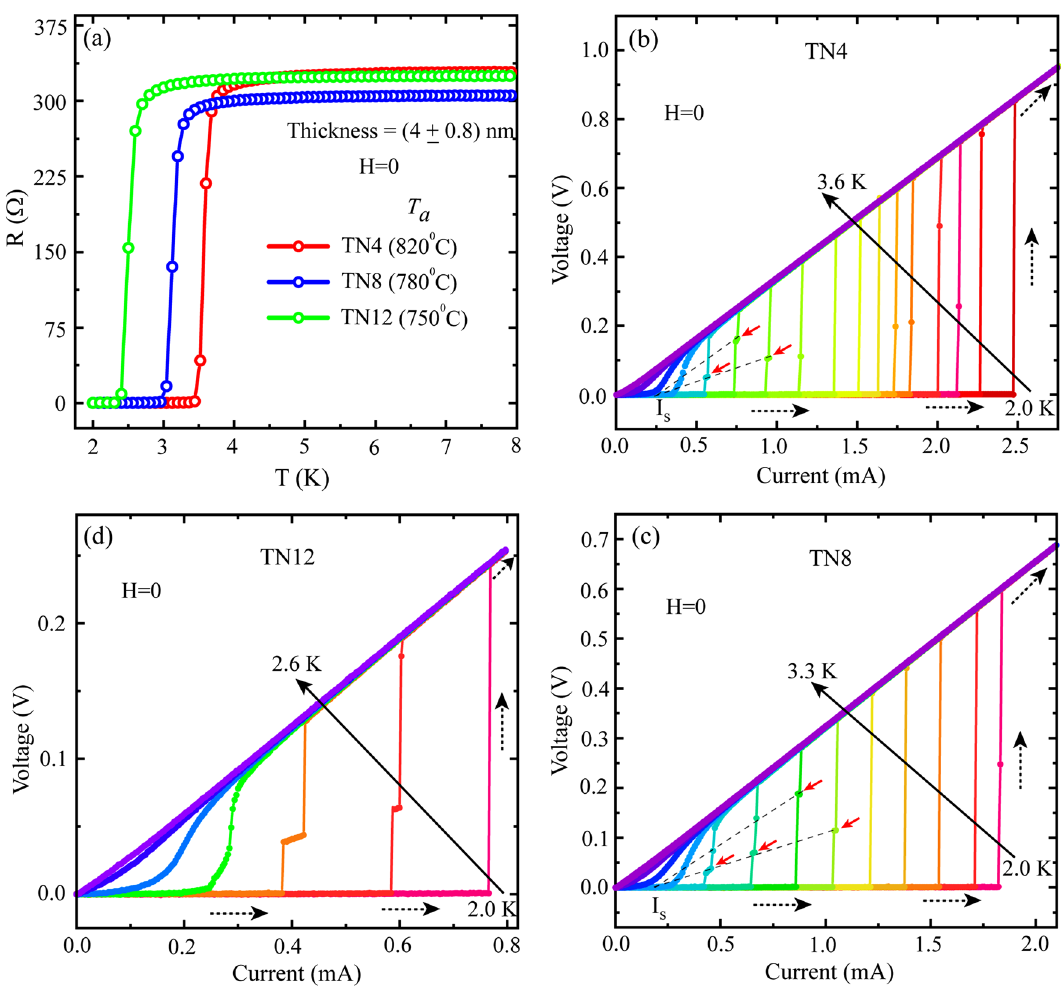
Figure 3. Zero-field current–voltage characteristics (IVCs). ( a ) Collection of R(T) data measured on three selected samples for which the IVCs are displayed in ( b – d ). The three representative samples (TN4, TN8 & TN12) are of same thickness (~ 5 nm) but were grown at different annealing temperatures. The IVC isotherms for ( b ) TN4 ( T a = 820 °C), ( c ) TN8 ( T a = 780 °C) and ( d ) TN12 ( T a = 750 °C). The black dashed arrows indicate the sweeping direction of the bias current along with the transition from superconducting to normal state. The solid black arrows specify the extent in measurement temperature starting from the base temperature (2.0 K) up to the T c with 0.1 K interval. Here, only the upward direction of current sweeping is considered while presenting the IVCs. The red arrows show the appearance of intermediate resistive